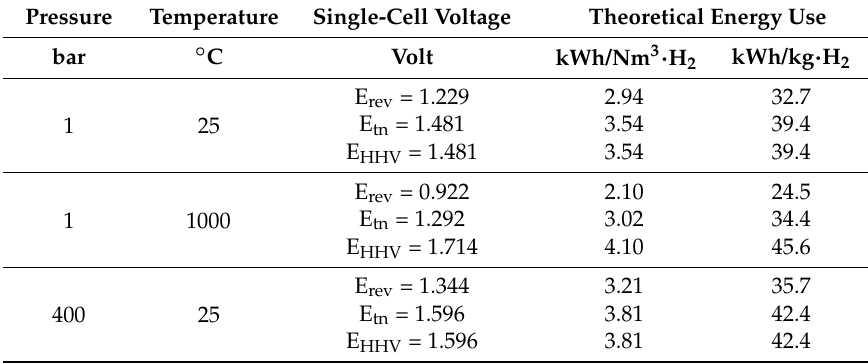
Table 2. Theoretical energy use of water electrolysis as a function of pressure and temperature, based